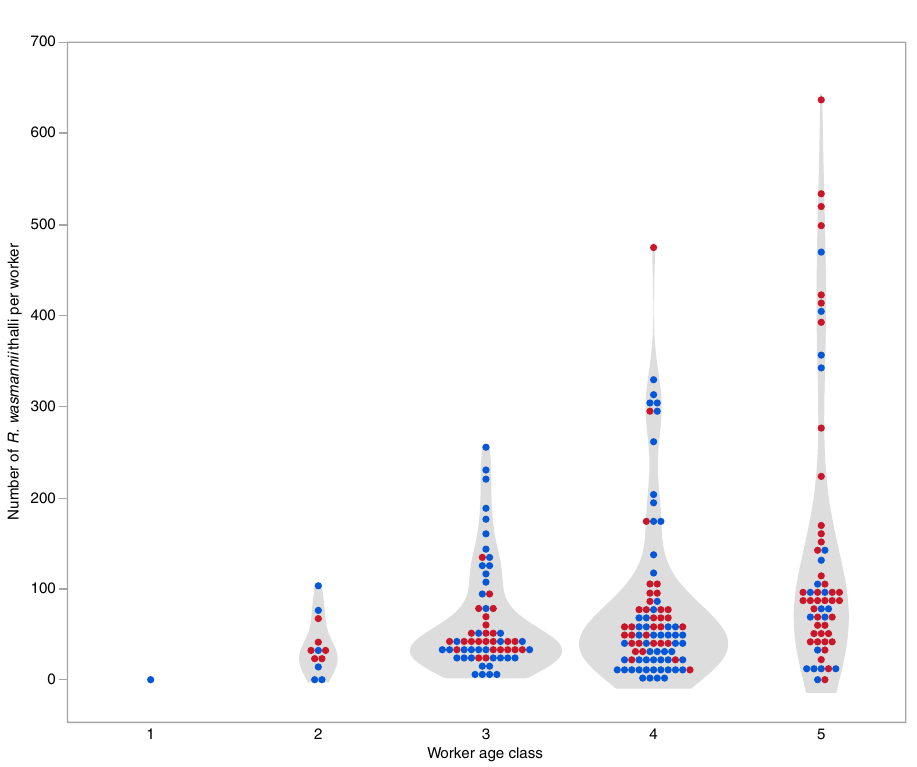
Figure 6. Box-plots summarising measurements of Phengaris alcon caterpillars before and during adoption by mini colonies of Myrmica scabrinodis that are either infected by Rickia wasmannii (red) or uninfected (blue). The whiskers show the entire range of observations.